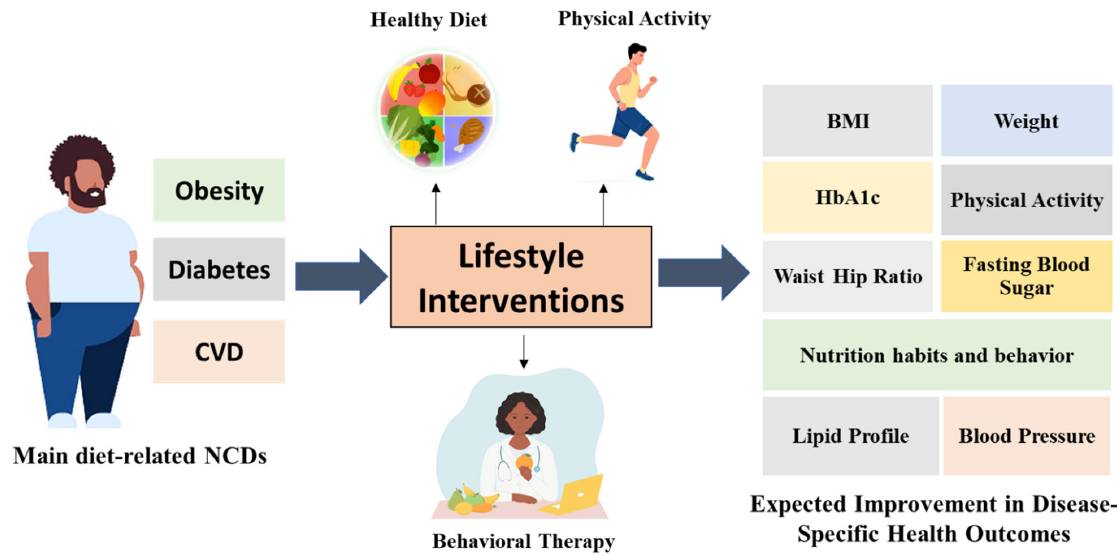
Figure 2. Lifestyle interventions for diet-linked NCD management and their impacts on health out ‐ comes.